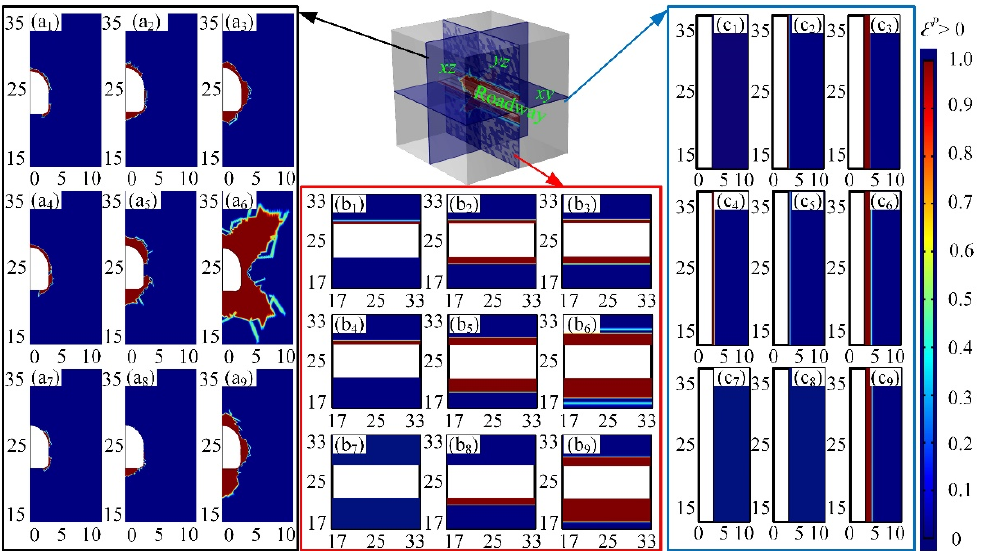
Figure 2. Distribution characteristics of plastic failure of roadway surrounding rock. ( a ) Plastic zone on xz plane, ( b ) plastic zone on yz plane, ( c ) plastic zone on xy plane. (a 1 ) λ x = 1, λ y = 1; (a 2 ) λ x = 2, λ y = 2; (a 3 ) λ x = 3, λ y = 3; (a 4 ) λ x = 1, λ y = 0.75; (a 5 )